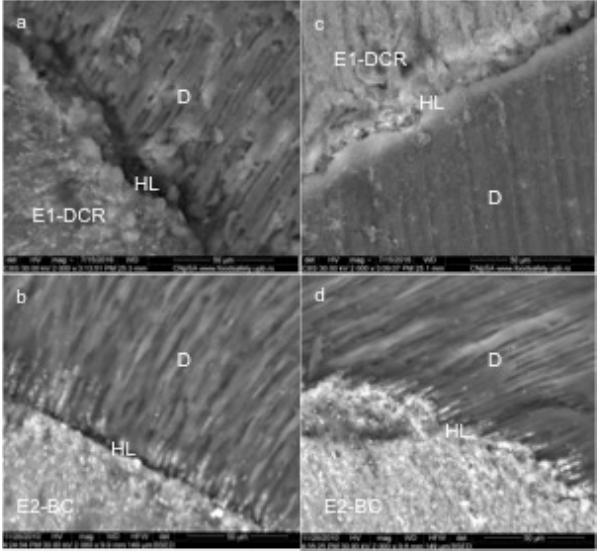
Figure 2. Representative SEM images of experimental sealers (magnification 2000X): dual cure resin experimental sealer E1-DCR ( a , c ); bioceramic experimental sealer E2-BC( b , d ); HL-hybrid layer, D-dentin.